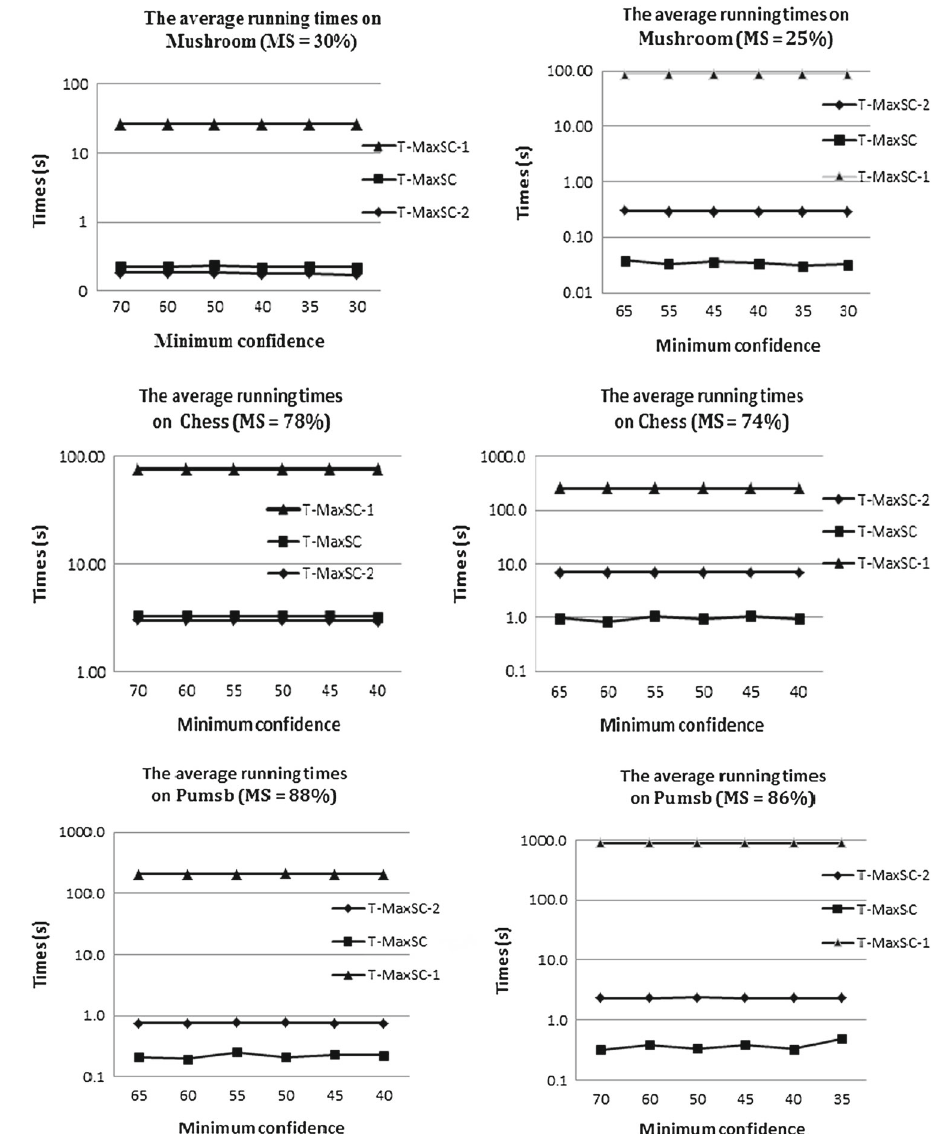
Fig. 6 Average running times of the three methods on Mushroom